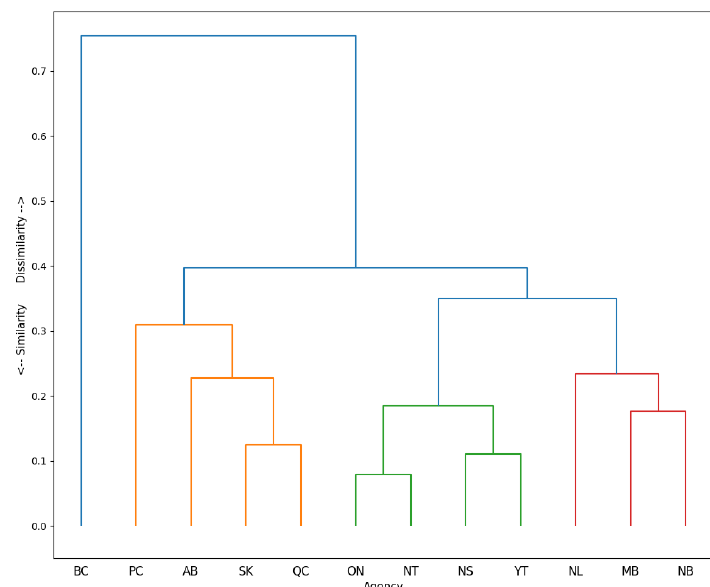
Figure 8. Dendrogram illustrating fire management agencies in similar clusters considering only indicators from agency familiarization with remote sensing data. We see that ON and NT are the most similar, then NS and YT (in green). In the orange group, SK and QC join first, then AB is added, followed by PC, and so forth.